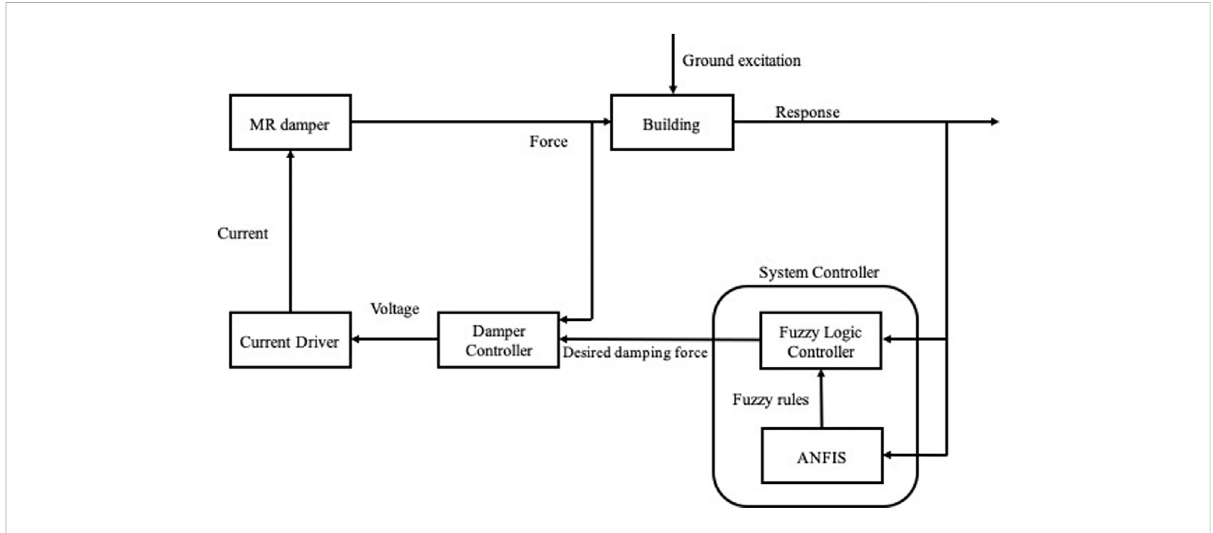
FIGURE 9 Block diagram of the semi-active system.